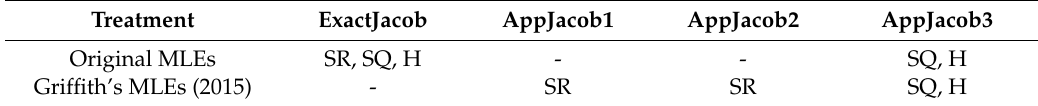
Table 4. Methods employed with a 10-by-10 lattice *.